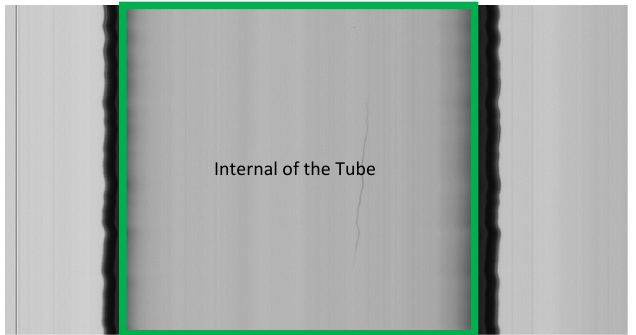
Figure 1. A tube image, where the region of interest (ROI) is highlighted or the internal of the tube. The frame is composed of 1000 × 2048 pixels, which corresponds to a tube length of 500 mm.